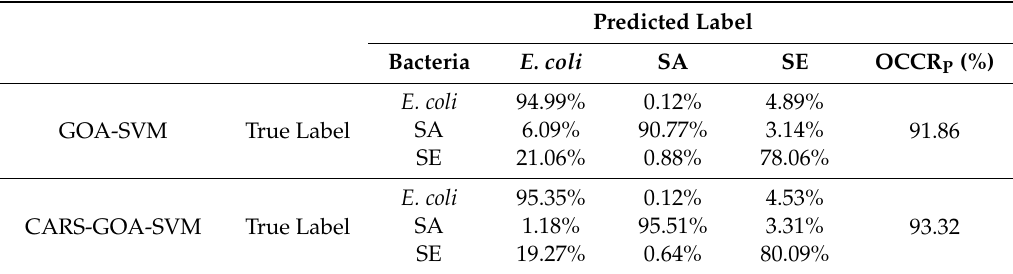
Table 5. Comparison of performance of predicting pixel-level spectral data using existing GOA-SVM and CARS-GOA-SVM